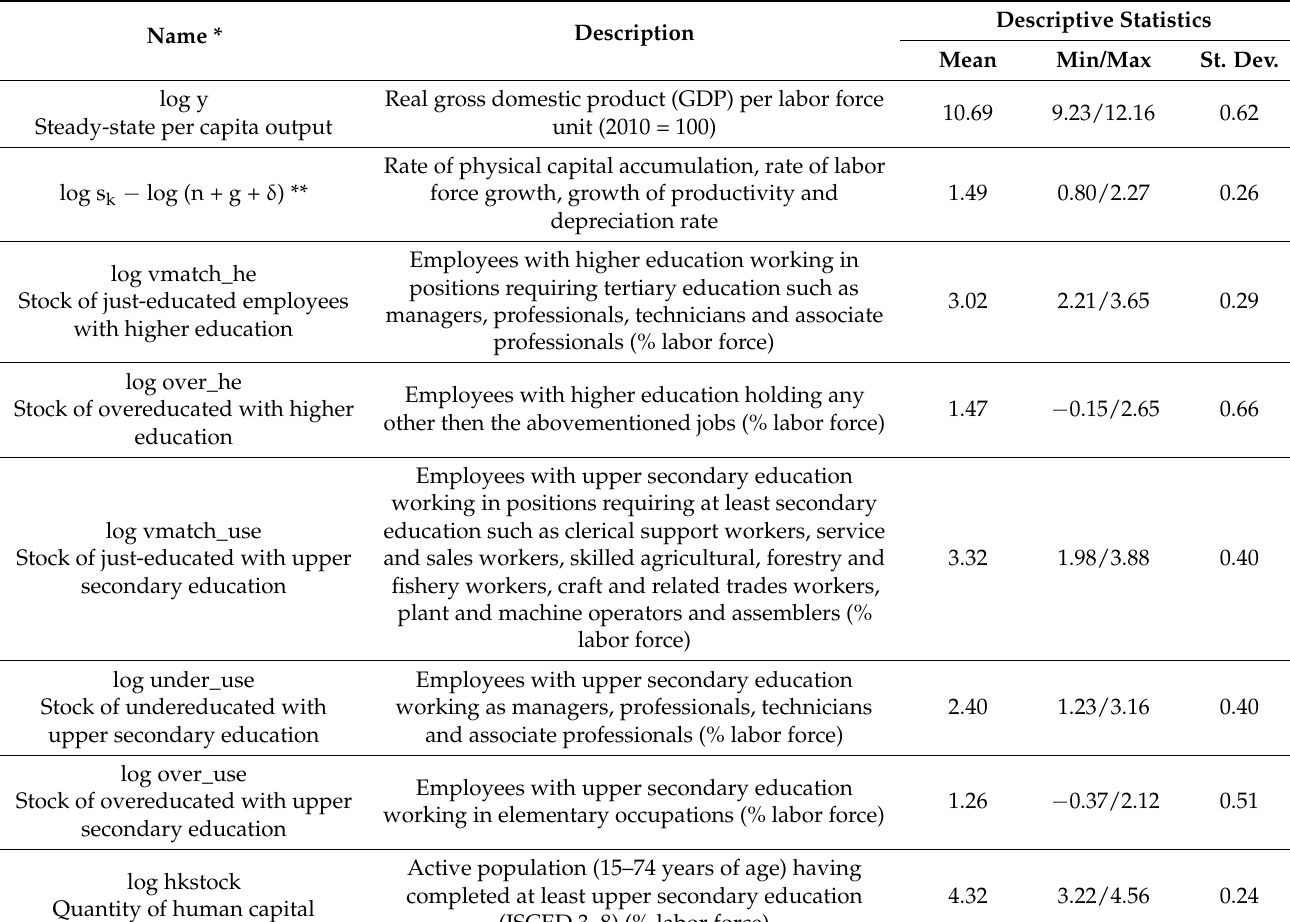
Table 1. Description of regression